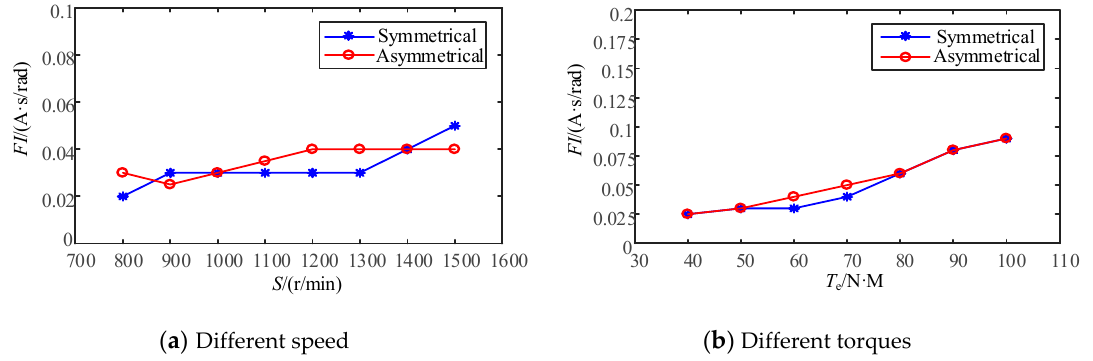
Figure 10. Fault indicators under conditions of motor symmetry and motor asymmetry.